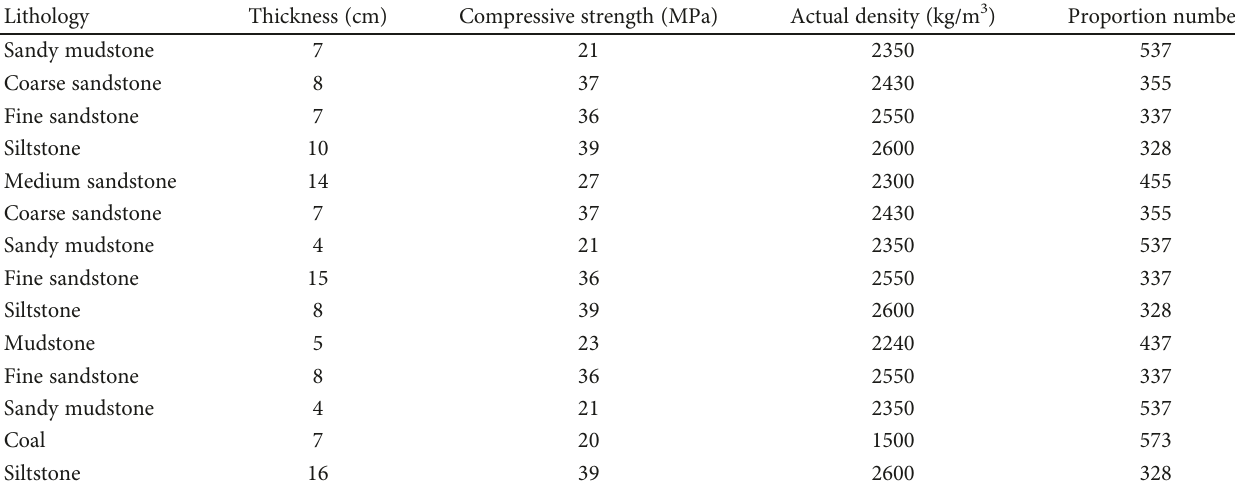
Table 2: Similar material proportion of the model.